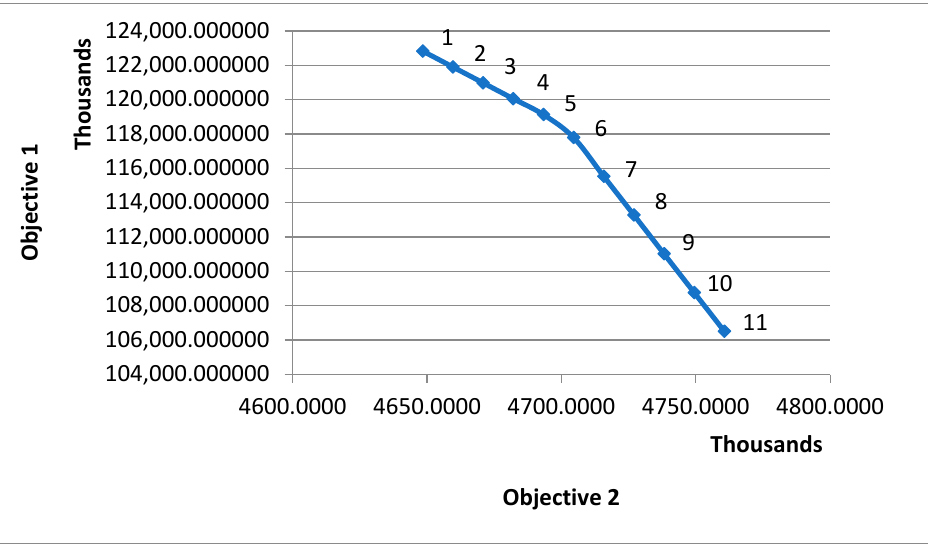
Figure 2. The Pareto front as formed for objectives 1 and 2 (functions f 1 (x) and f 2 (x), respectively).